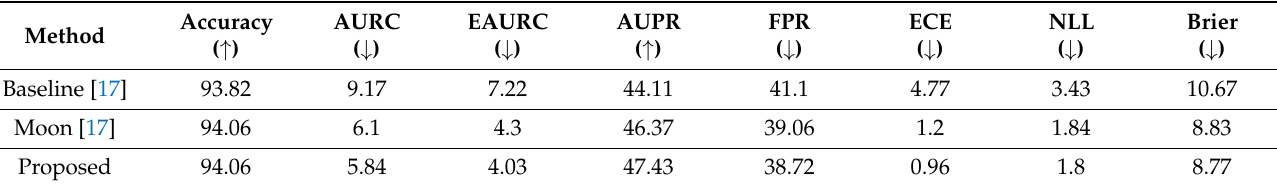
Table 1. Comparison of ResNet50.